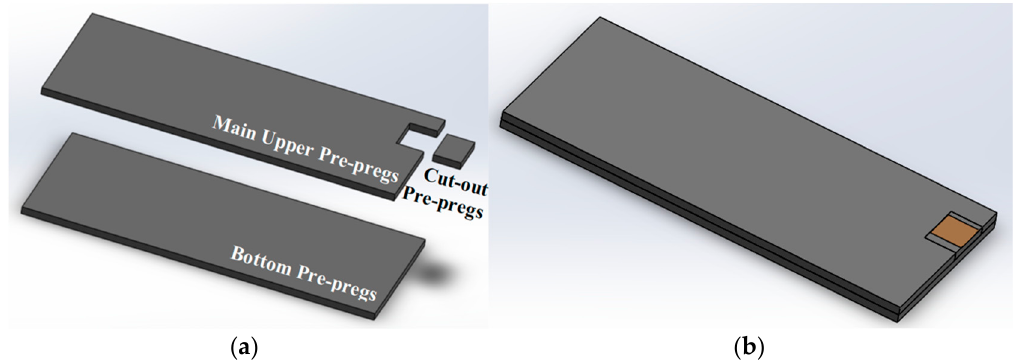
Figure 2. Schematics of ( a ) ply ‐ cutting plan, ( b ) pre ‐ pregs assembly model.